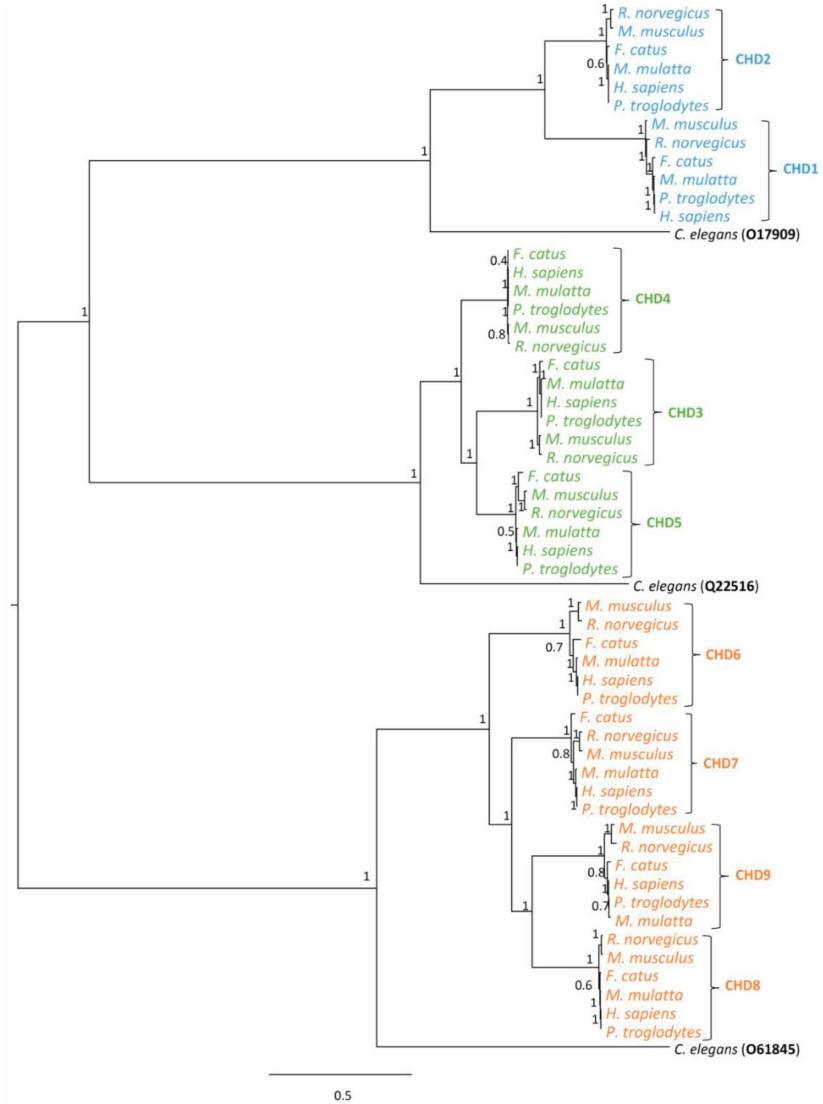
Figure 1. Phylogenetic tree for the CHD family of proteins. Evolutionary model was determined automatically using the built it SMS [56] option in PhyML 3.0 [57] resulting in JTT+G+I. Branch support values shown at tree nodes correspond to posterior probabilities determined using aBayes [58]. The highlighting represents each protein group (blue: group I; green: group II and orange: group